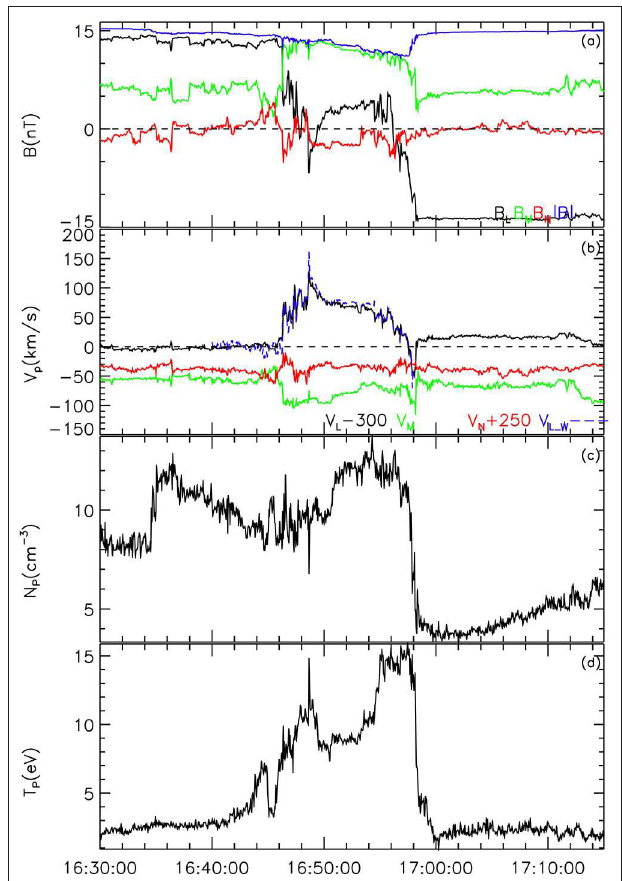
FIGURE 2 | The enlarged vision of current sheet (the shadow region in Figure 1 ) in the LMN coordinate system. (a) Magnitude (blue) and three components of the magnetic field, L (black), M (green), and N (red). (b) Three components of plasma velocity. The dashed blue line represent the velocity predicted by walen relation. Note that the origin data curves have been shifted up or down for clarity. (c–d) The proton density and temperature.